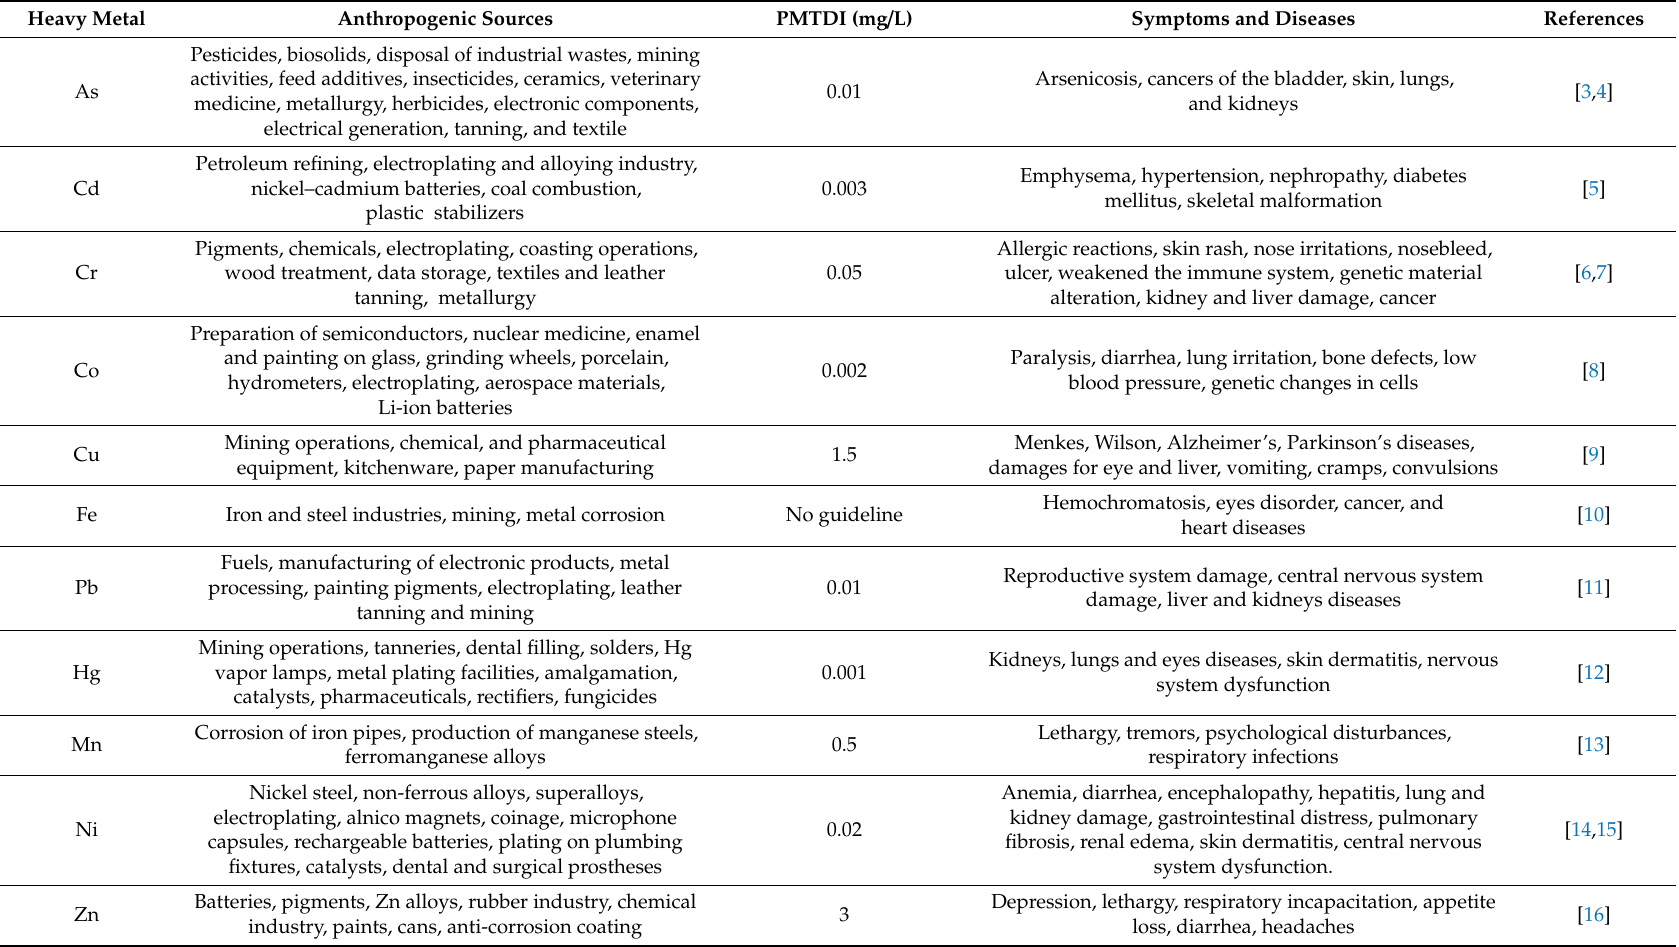
Table 1. Comparison of selected heavy metals, their anthropogenic sources, provisional maximum tolerable daily intake (PMTDI) according to WHO, and symptoms and